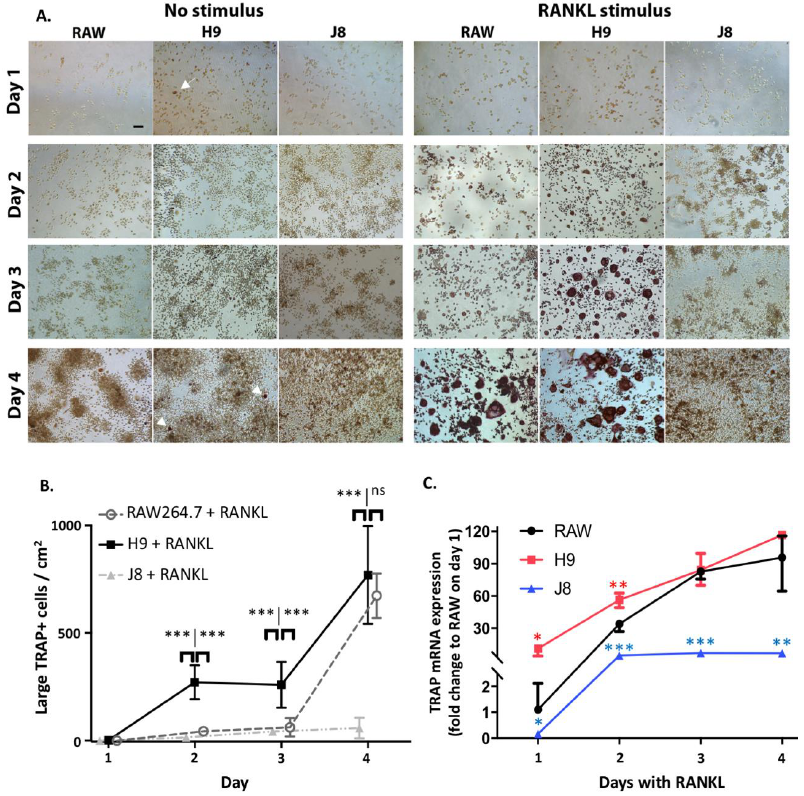
Figure 4. Time-dependent formation of osteoclasts in unstimulated and RANKL-stimulated RAW264.7 and sub-clones H9 and J8. ( A ) TRAP staining of unstimulated and RANKL-stimulated RAW 264, H9 and J8 cells after 1–4 days. Scale bar 100 μm, all subplots have the same magnification. Arrows point to TRAP-positive cells on Day 1 and TRAP-positive multinuclear cells on Day 4. ( B ) Quantification of the number of large TRAP+ cells/cm 2 in RANKL-stimulated RAW264.7, H9 and J8 cells (mean ± SD, n = 3). The 100-pixel area corresponds to an area of 85 µm 2 and the average size of a mononuclear cell is between 50–300 µm 2 , while the threshold for large (multinuclear) cells was set for 300 µm 2 . Statistics were done by one-way ANOVA followed by Turkey’s multiple comparison test ( C ) TRAP mRNA expression in RANKL-stimulated RAW264.7, H9 and J8 cells after 1–4 days ( n = 3). Statistics were done with two-tailed multiple t -test comparing the sub-clones to parental line. * p < 0.05, ** p < 0.01, *** p <